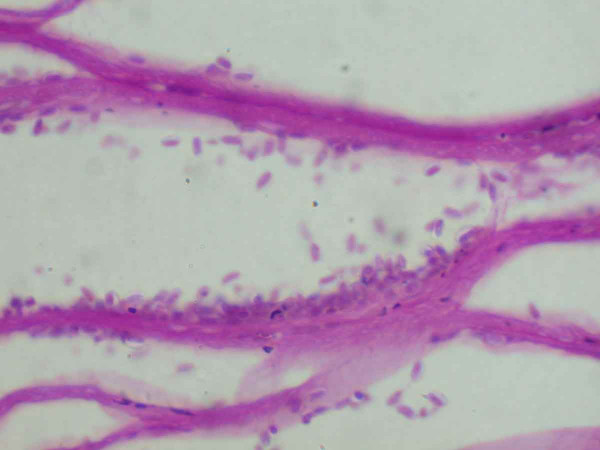
Section of corneal button of case 4 showing the presence of oval, spores of microsporidia in the stroma, unaccompanied by inflammatory infiltrates (PAS stain, ×500).